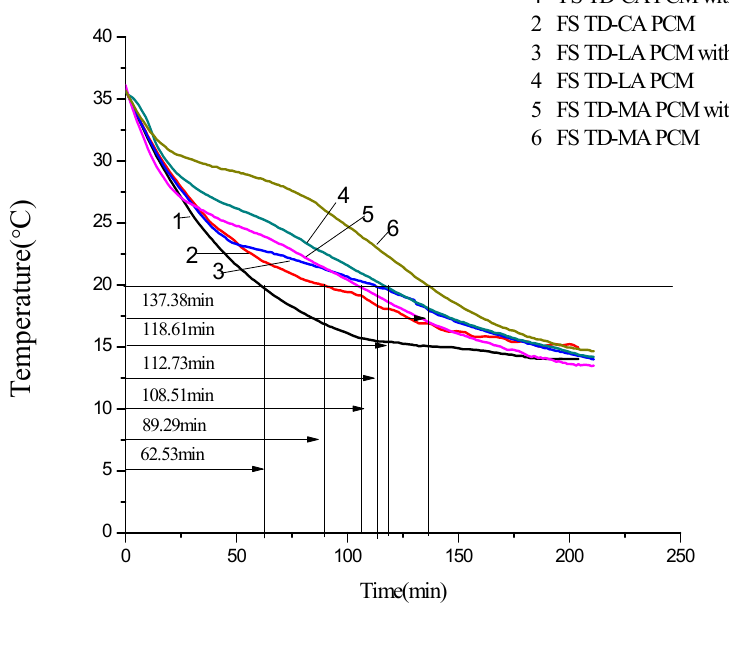
Figure 15. Comparison diagram of solidification temperature curves between FS TD-CA PCM, FS TD-LA PCM, and FS TD-MA PCM with/without